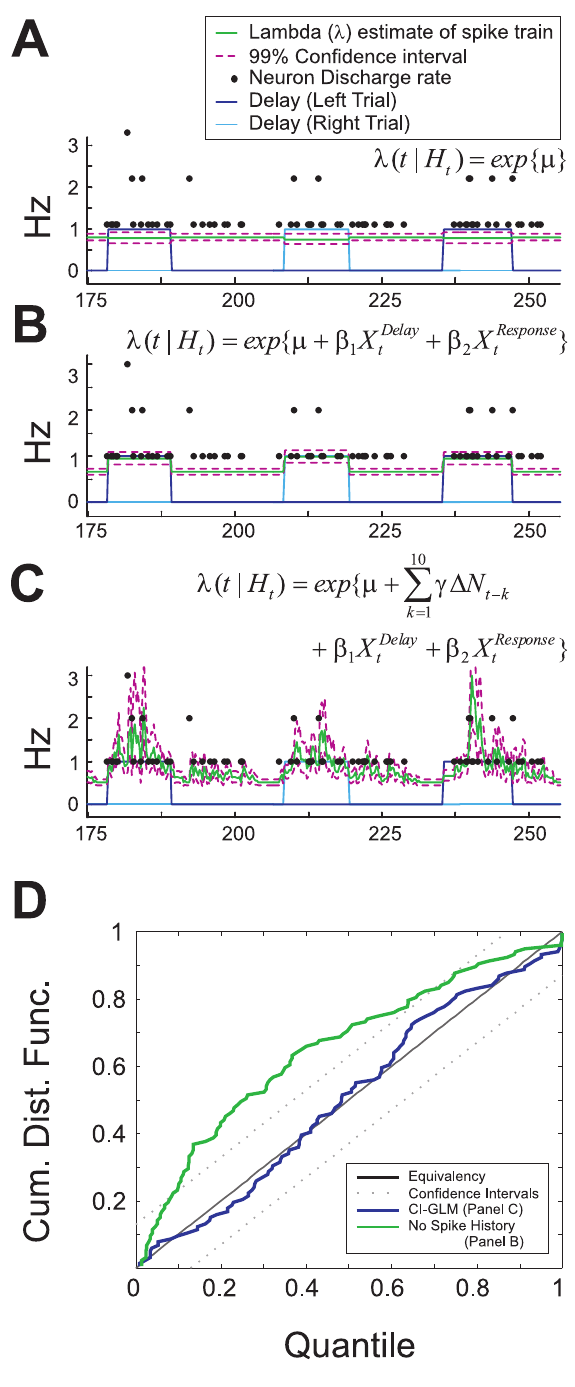
Figure 6. Characterization of generalized linear models of task- related activity. Plot of 80 seconds of spike train data, spanning three trials and fit with a GLM using ( A ) a homogeneous Poisson model, ( B ) an inhomogeneous Poisson model, and ( C ) an a conditional intensity model (Model 1b, during baseline conditions only). Spike counts of the original spike train are plotted with black dots against lambda ( l ; green line with red confidence intervals). X-axis=experimental time. D ) Kolmogorov–Smirnov (K-S) goodness-of-fit plot demonstrates that incorporation of spike history improves performance of the CI-GLM (blue vs. green line). The K-S plot of the final model (blue line; model from panel C) falls within equivalency confidence intervals of the K-S test (diagonal solid and dotted lines) for all quantiles, indicating that inclusion of spike history with behavioral intervals in the CI-GLM